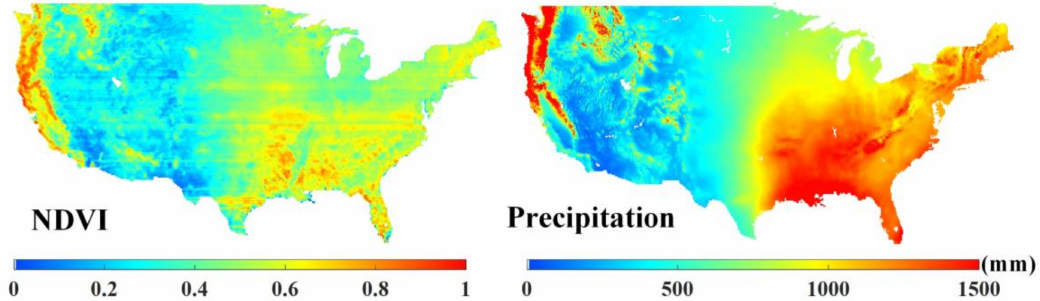
Figure 3. Maps of 30-year averaged normalized di ff erential vegetation index (NDVI) and precipitation over the contiguous United